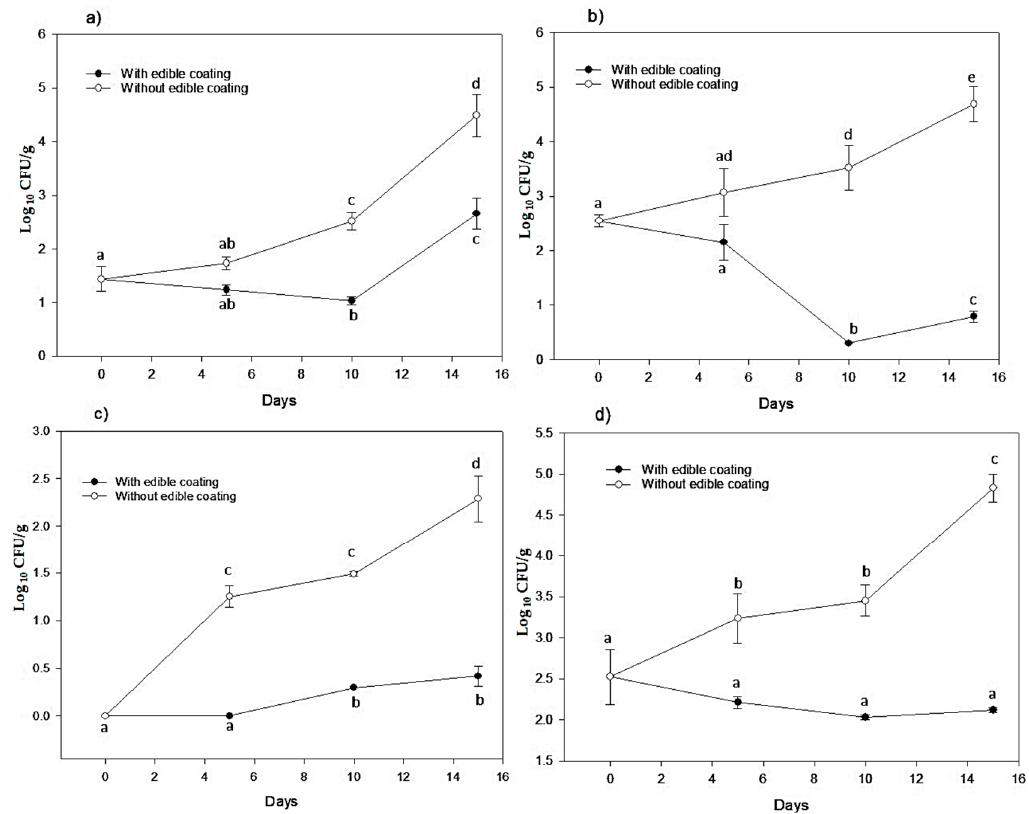
Figure 5. Antimicrobial activity of papaya with and without edible coating: ( a ) total coliforms; ( b ) mesophilic aerobic bacterial; ( c ) fungi; ( d ) yeasts. a–e: used on top of reported values, indicate that if the same letter appears at different times, the values compared are not significantly different ( p > 0.05).